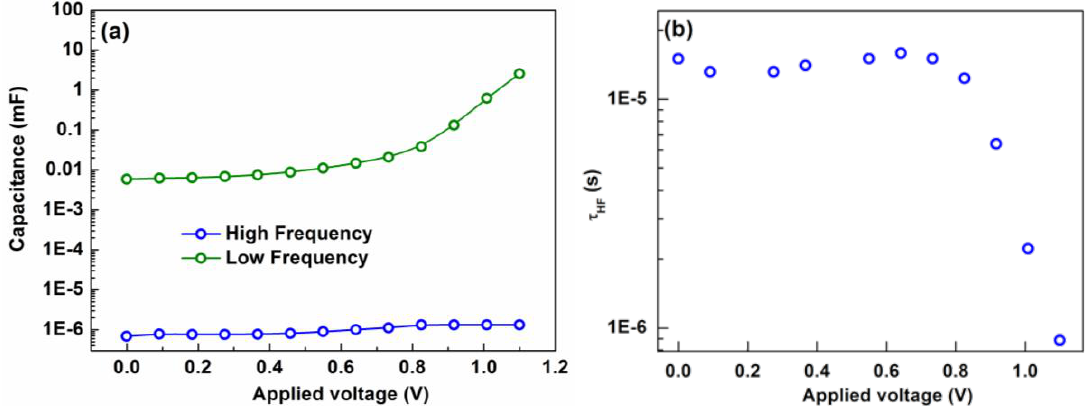
Figure 5. ( a ) The capacitance of a PSC extracted from the low and high frequency Nyquist spectra as a function of applied bias and ( b ) the variation of the high frequency time constant as a function of applied bias for a PSC.